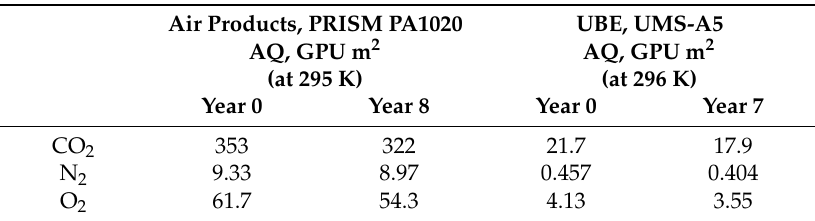
Table 3. Module permeance of carbon dioxide, nitrogen, and oxygen in Air Products PRISM PA1020 and UBE UMS-A5